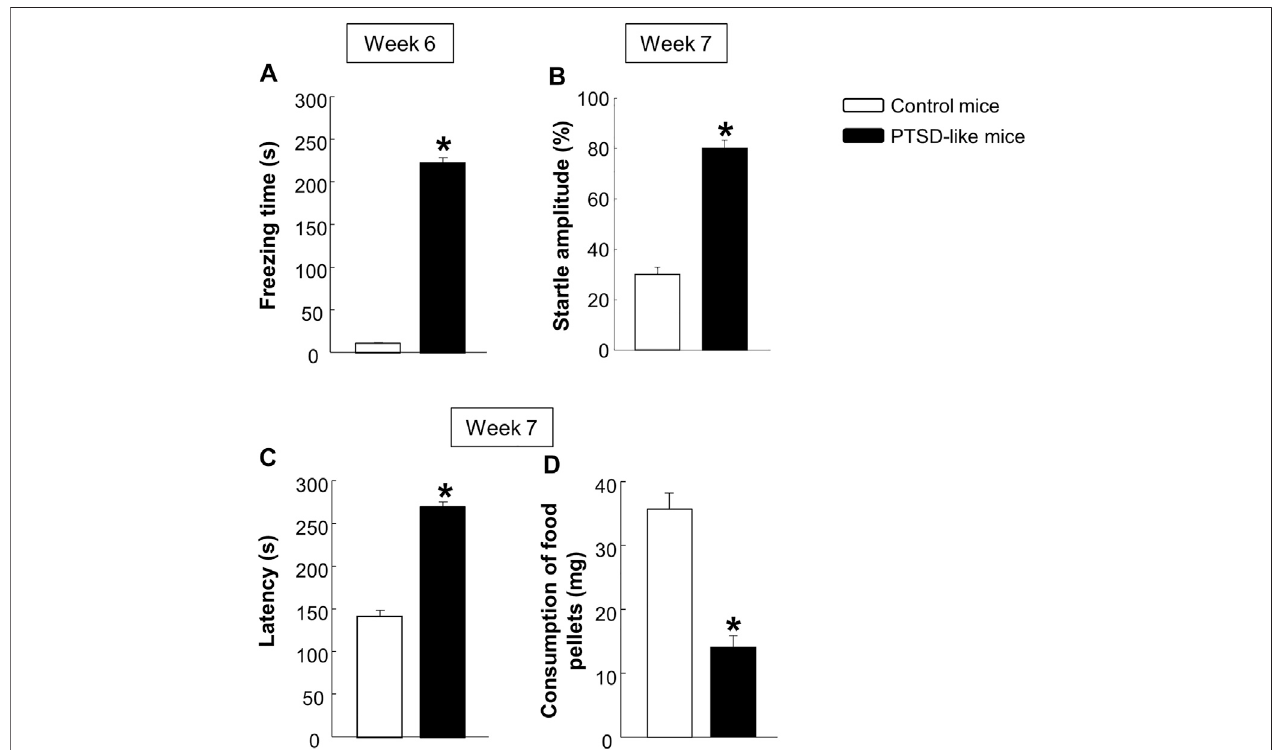
FIGURE 2 | Evaluation of the basal behavioral disturbances induced by the animal model of PTSD at weeks 6 and 7. Analysis of the freezing time (s) by the fear conditioning (FC) paradigm (A) , the startle amplitude (B) by the acoustic startle response (ASR), and of the latency time (C) and food pellets consumption (D) by the novelty suppressed feeding test (NSFT). Columns represent the mean and vertical lines ± SEM. *, Values from PTSD-like mice that are signi fi cantly different from control mice (Student ’ s t -test, p < 0.001). Mice exposed to the PTSD-like model: N (cid:2) 8; control mice: N (cid:2)